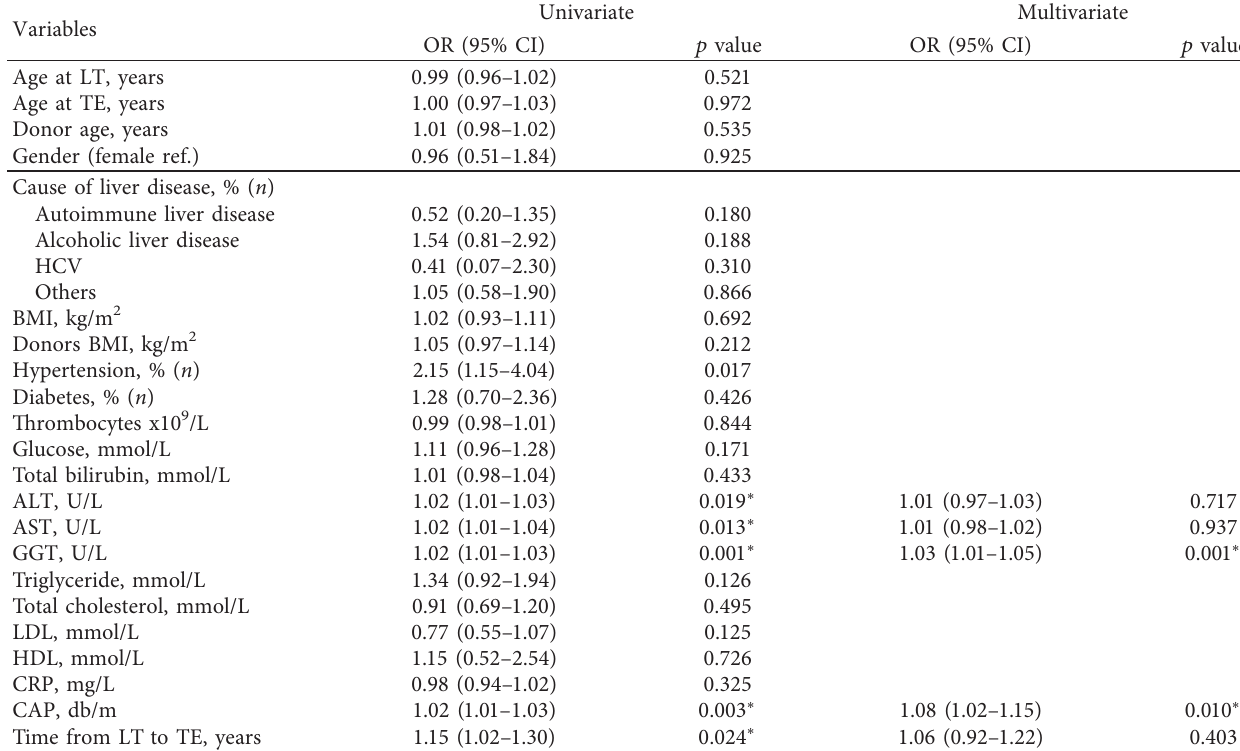
Table 7: Univariate and multivariate analysis of predictors of moderate